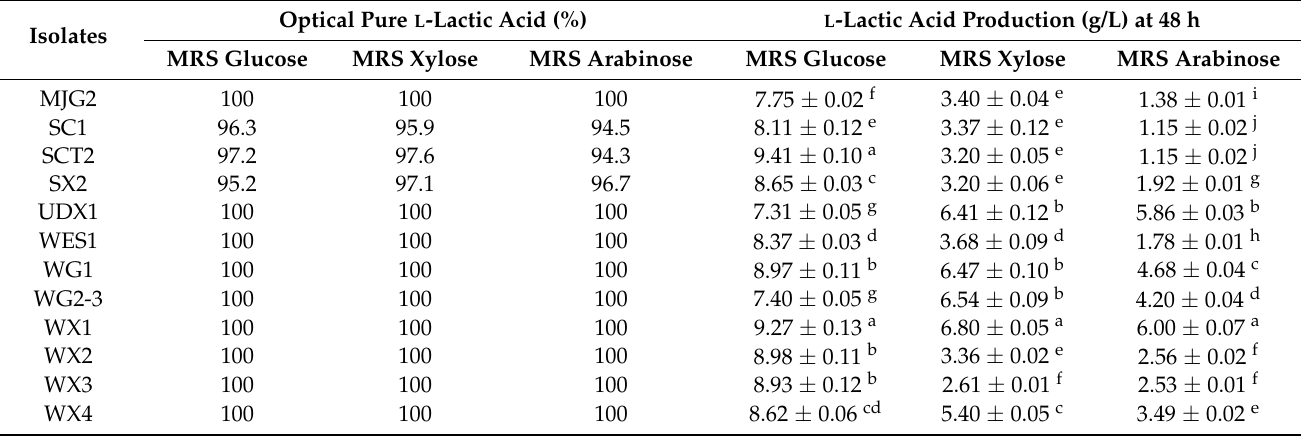
Table 1. Enantiomeric purity of L -lactic acid production from glucose, xylose and arabinose at 10 g/L concentration in MRS broth by twelve selected presumptive LAB under static condition at 37 ◦ C for 48 h. Optical Pure L -Lactic Acid (%) L -Lactic Acid Production (g/L) at 48 h Isolates MRS Glucose MRS Xylose MRS Arabinose MRS